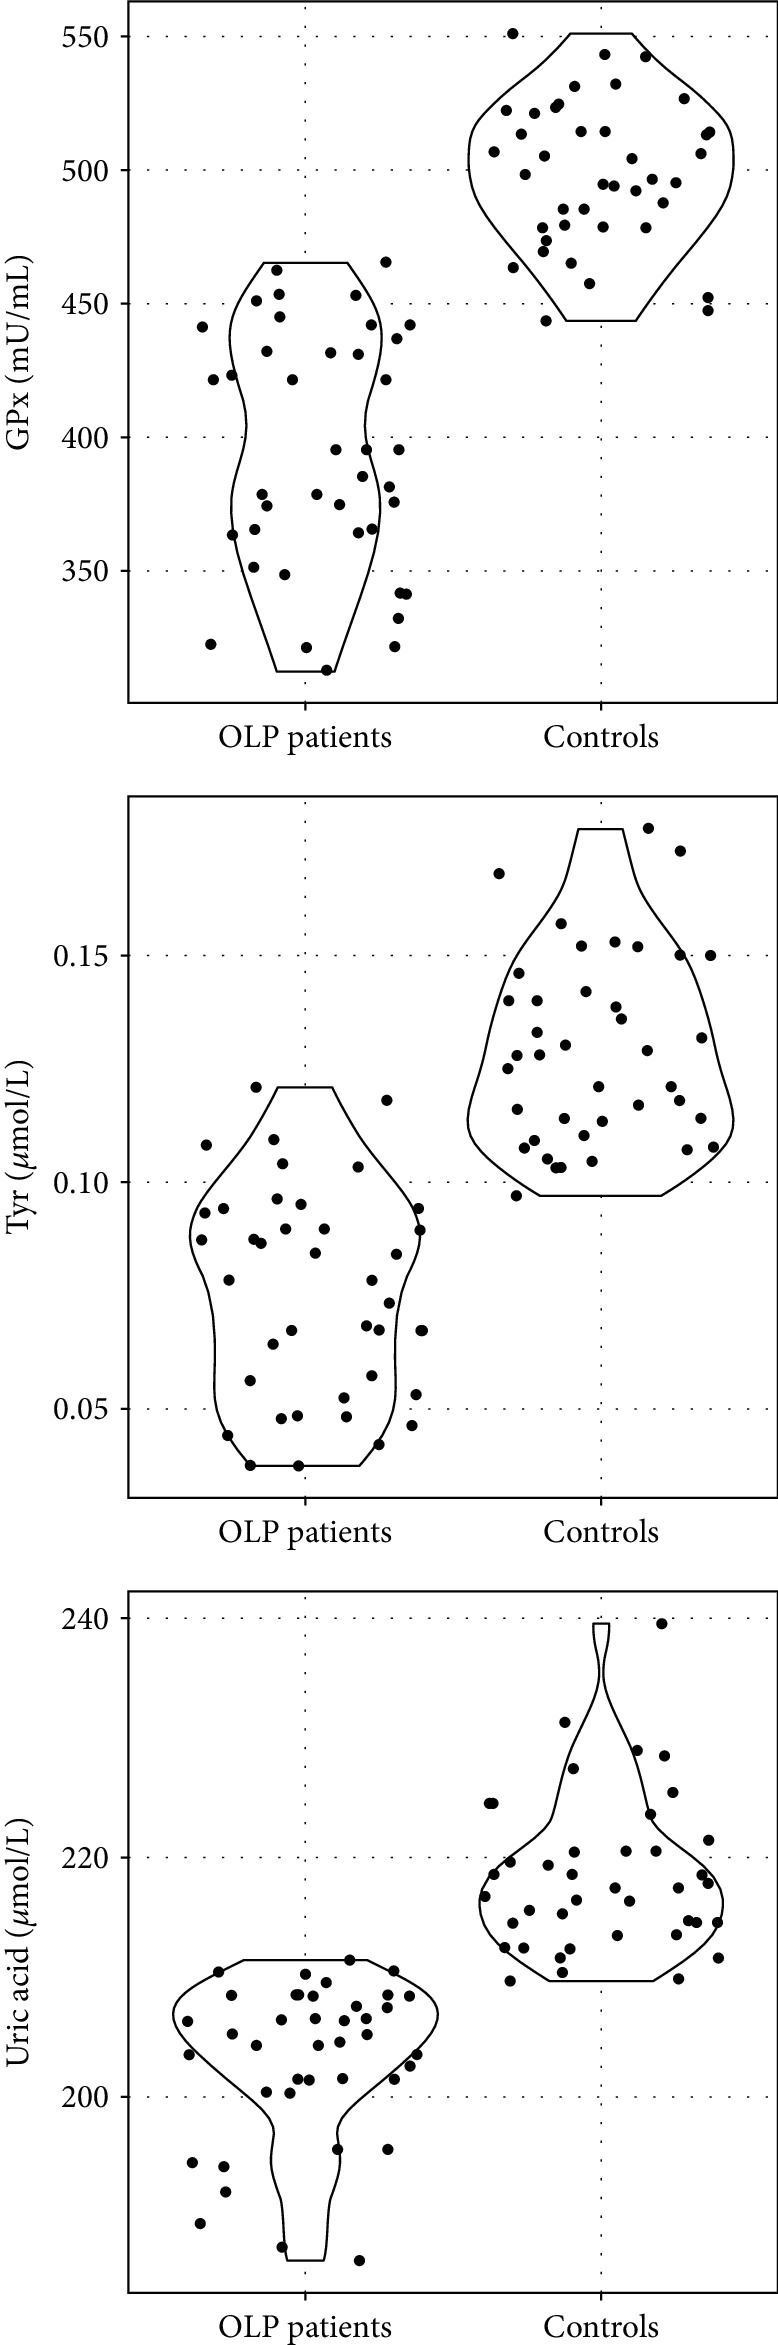
Violin plot representing tyrosine (Tyr), uric acid (UA), and glutathione peroxidase (GPx) activity in the group of OLP patients and controls. The dots on the graph represent individual results in each group.